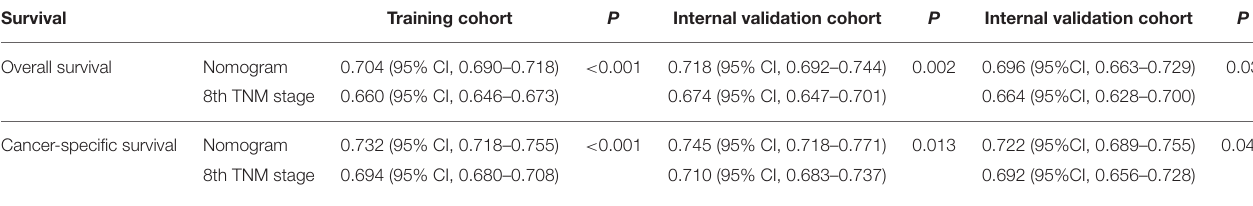
TABLE 3 | C-indexes for the nomograms and TNM stage systems in patients with gallbladder carcinoma.